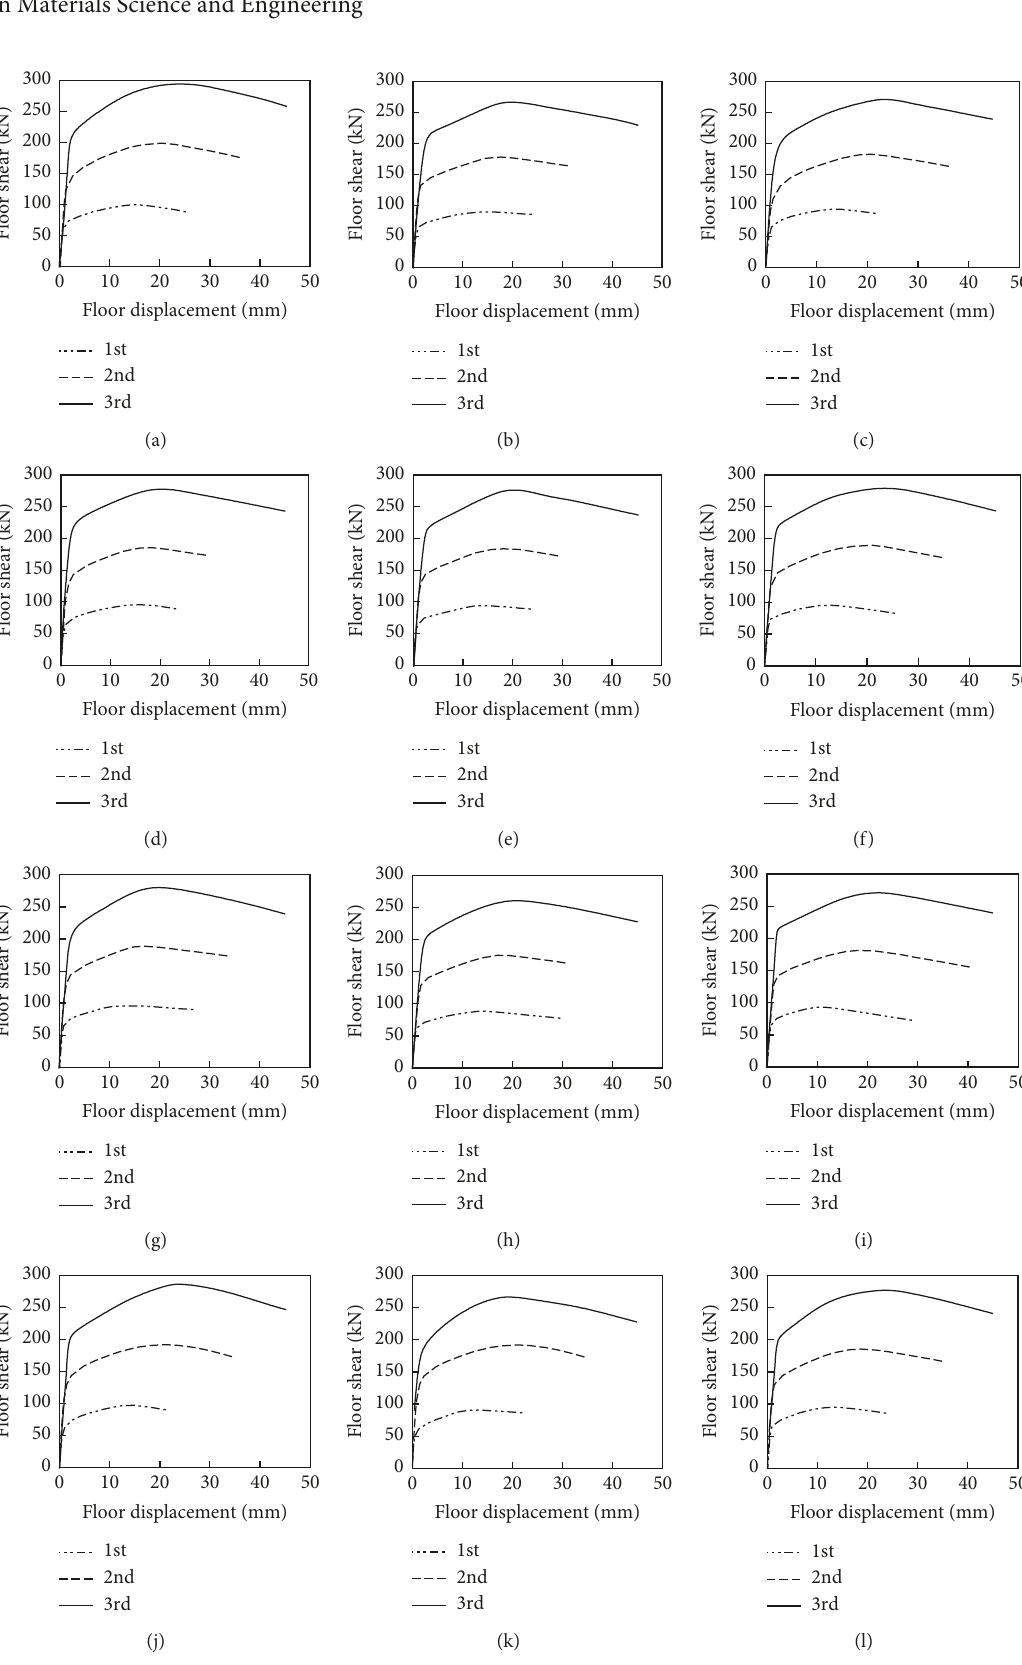
Model MaS3-7 (0.1g) . (a) Intact structure model. (b) Dem 1|1&4/B-C. (c) < >